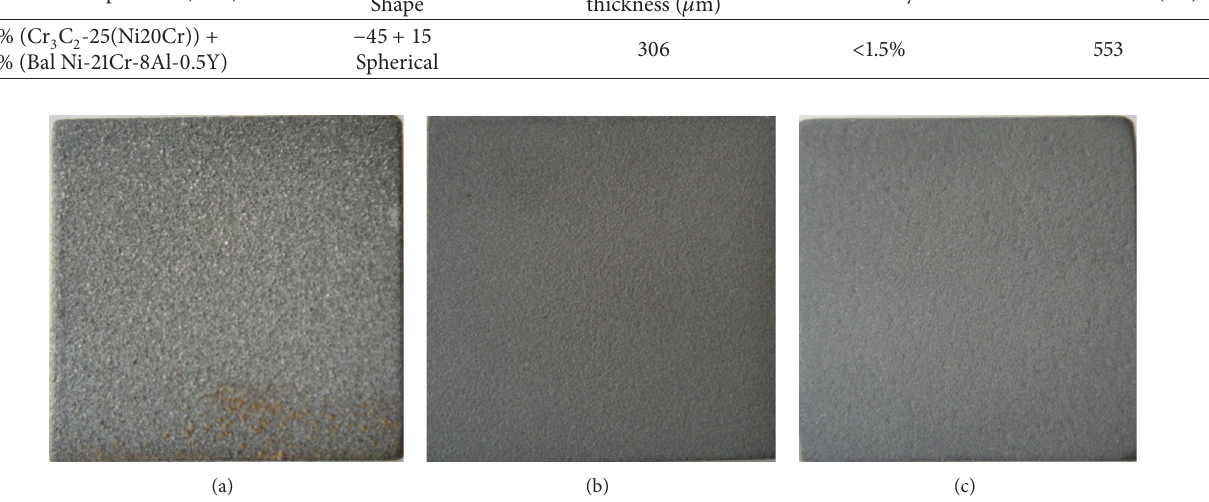
Table 2: Composition of the feedstock alloys, coating thickness, and porosity. Chemical composition (wt%)